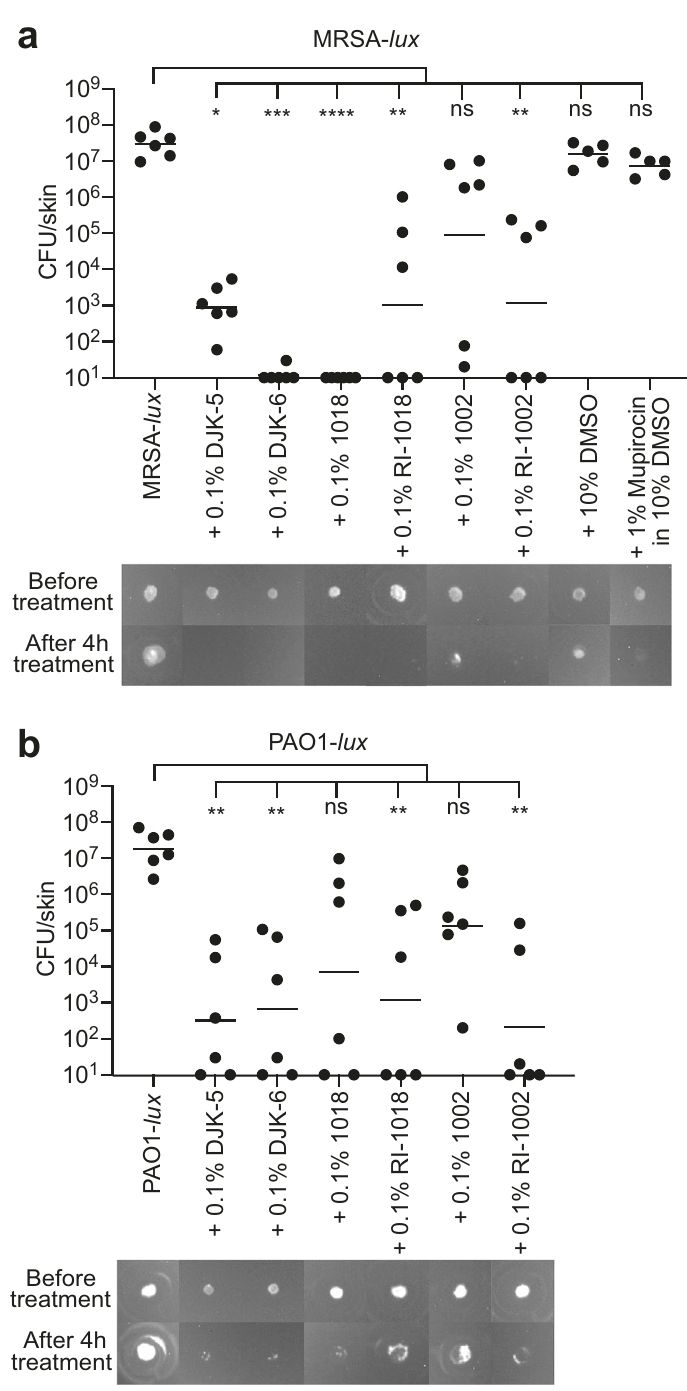
Fig. 4 Differential antibio fi lm activities of synthetic host defense peptides on epidermal skin bio fi lms. One day pre-established MRSA- lux ( a ) or PAO1- lux ( b ) bio fi lm were treated topically for 4 h with 0.1% of various synthetic HDPs, or 1% mupirocin dissolved in 10% DMSO, and the colony count recovered from each skin sample was determined. Luminescence signals from colonized MRSA- lux ( a ) and PAO1- lux ( b ) were imaged using the ChemiDoc Imaging System. Statistical signi fi cance (* P ≤ 0.05; ** P ≤ 0.01; *** P ≤ 0.001; **** P ≤ 0.0001) comparing peptide treated skins to MRSA- lux or PAO1- lux control was performed using the Kruskal – Wallis test, Dunn ’ s multiple comparisons test. Geometric mean of CFU count from 5 to 6 biological replicates was PAO1- lux (Fig. 4b) bio fi lms in the context of this human organoid antibio fi lm ef fi cacies among the evaluated peptides that could be system within 4 h of treatment. Peptides DJK-5, RI-1018, and qualitatively assessed based on the luminescence (representative RI-1002 showed comparable antibio fi lm activity against MRSA- lux images shown in Fig. 4 bottom panel) or quanti fi ed by recovering and PAO1- lux , whereas DJK-6 and 1018 had superior effects CFUs following peptide treatment. All of the peptides except in eradicating MRSA- lux bio fi lms. Notably, mupirocin, a 1002 signi fi cantly reduced pre-established MRSA- lux (Fig. 4a) and